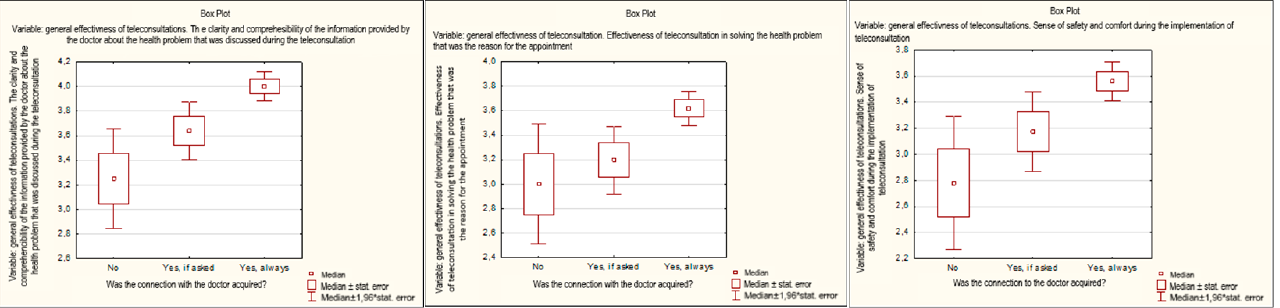
Figure 3. Ability to have a direct conversation with a doctor and the components of the overall assessment of the effectiveness of teleconsultations.